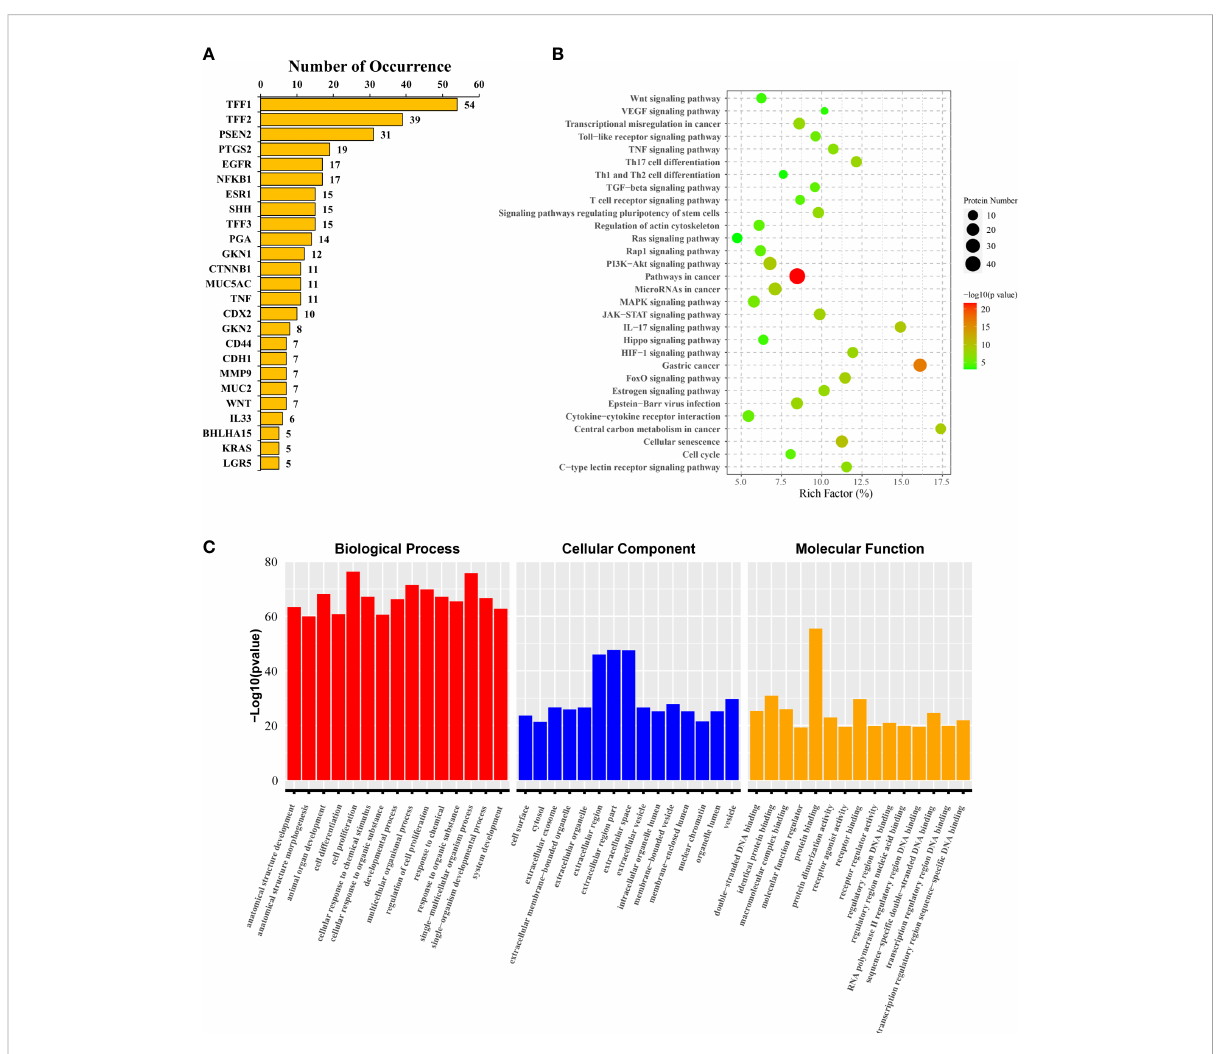
FIGURE 7 Target genes and pathways annotated for SPEM-GC. (A) The 25 high-frequency genes. (B) KEGG pathway enrichment analysis results of 147 literature gene keywords. (C) GO functional annotation and enrichment analysis results of the literature gene